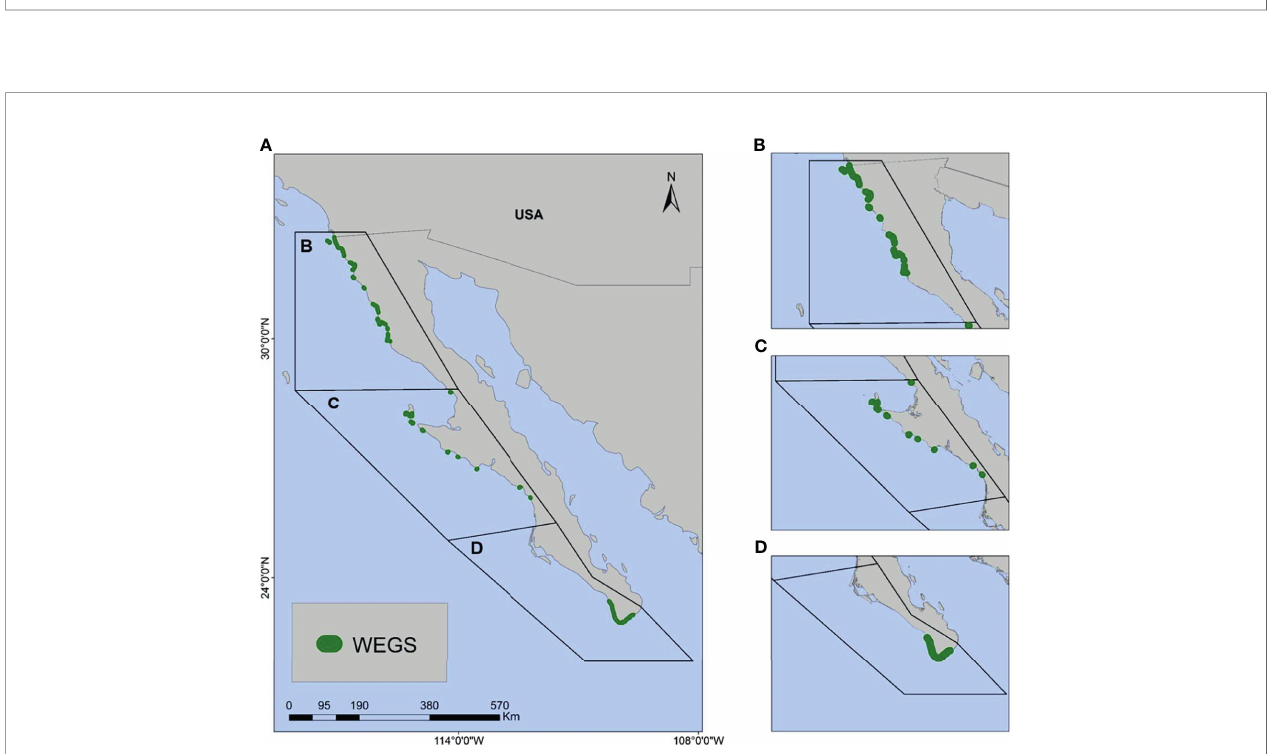
FIGURE 9 | Spatial distribution of WEGS along the Paci fi c coast of the peninsula. (A) all the peninsula, (B) the northern part, (C) central, and (D) southern part of the